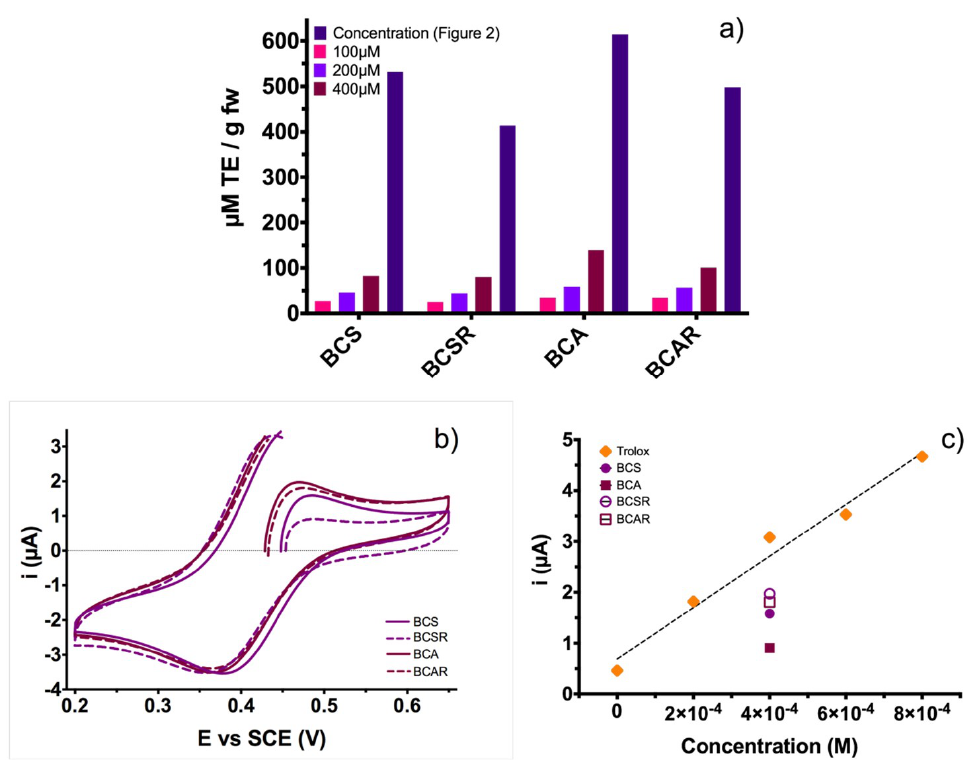
Figure 7. ( a ) Antiradical activity of black carrot extracts using DPPH assay at different concentrations. ( b ) Cyclic voltammograms for the four extracts (400 µ M) in a CUPRAC solution. The scan began at the open circuit potential (OCP) with a sweep velocity of 100 mV · s − 1 . ( c ) Electrochemical antioxidant activity and compared with Trolox activity at the same concentration. Samples extracted with ethanol/citric acid (BCS) and ethanol/acetic acid (BCA), samples after resin column (BCSR and BCAR).